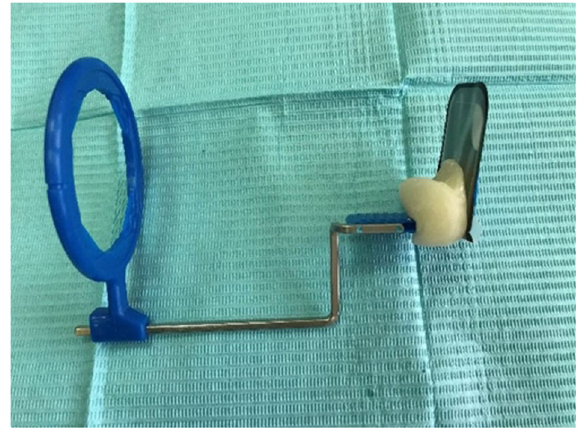
Fig. 2 Individualized extension cone paralleling